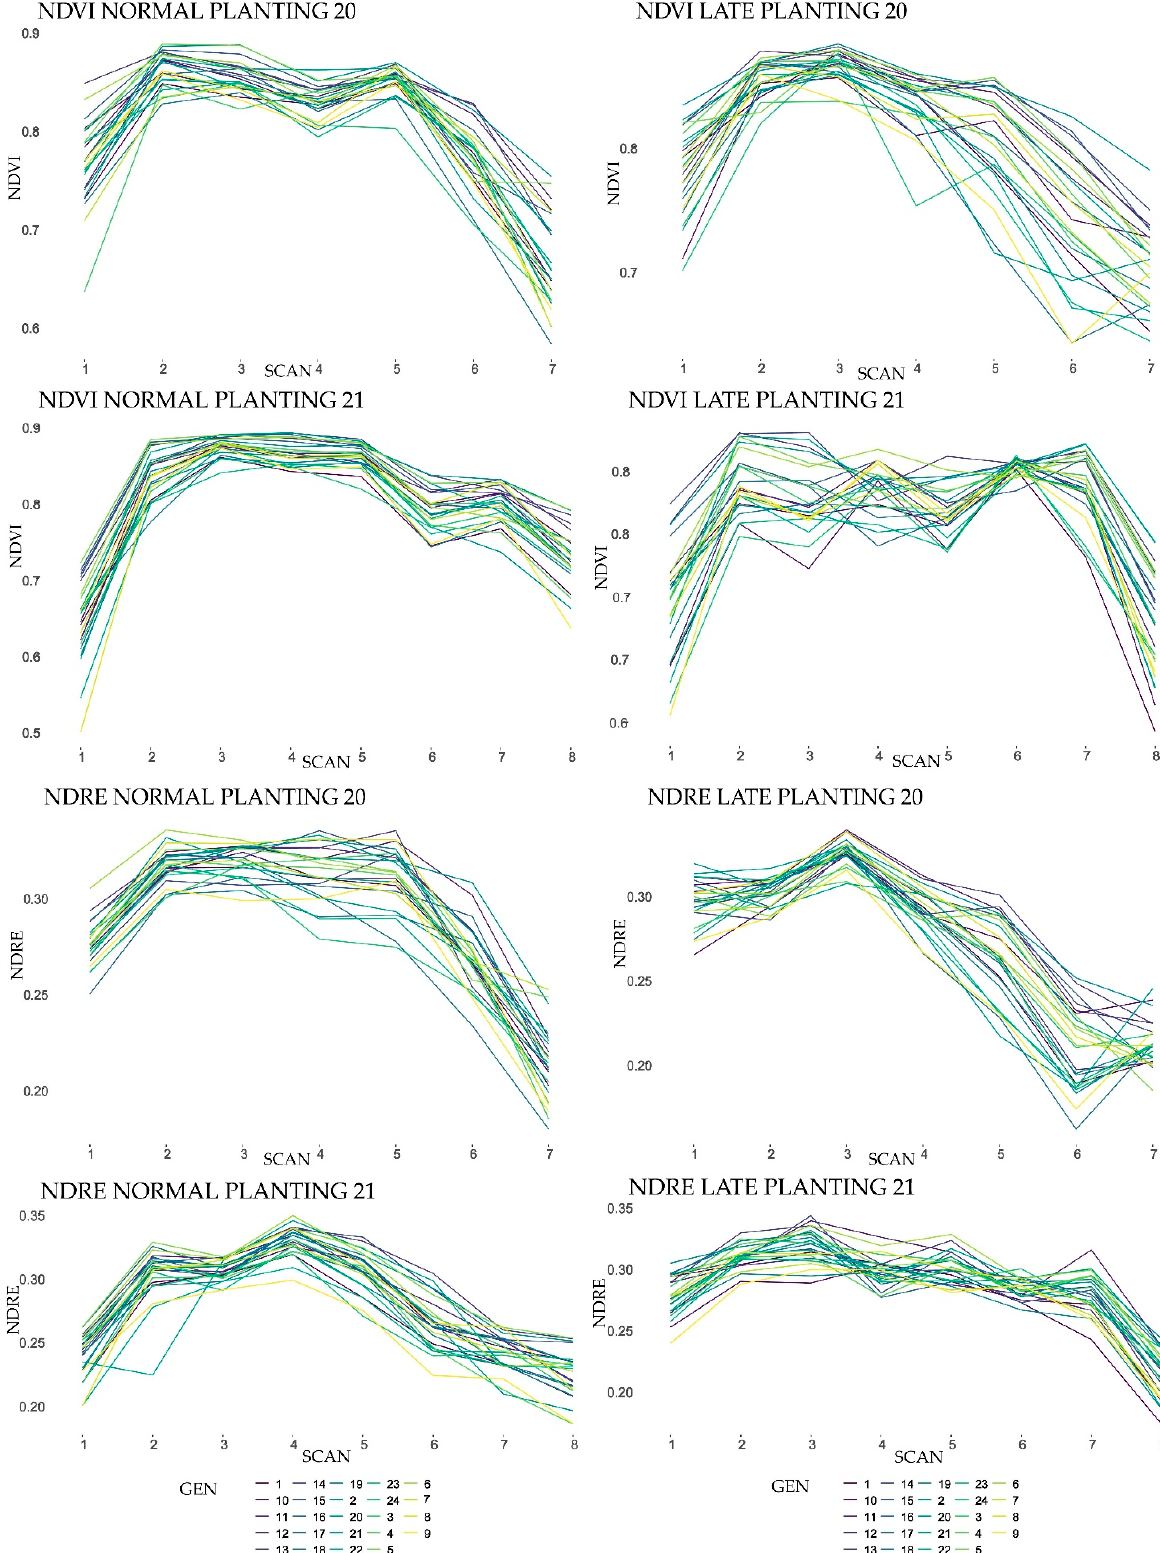
Figure 4. Pattern of GDD accumulation rates for both growing conditions and cropping years. Shown is the fitted linear regression line for the GDD parameters, along with the equations and R 2 . Scanning dates in dependence with GDD and sesame phenology phases (VS = vegetative stage, RES = reproductive stage, RIS = ripening stage).